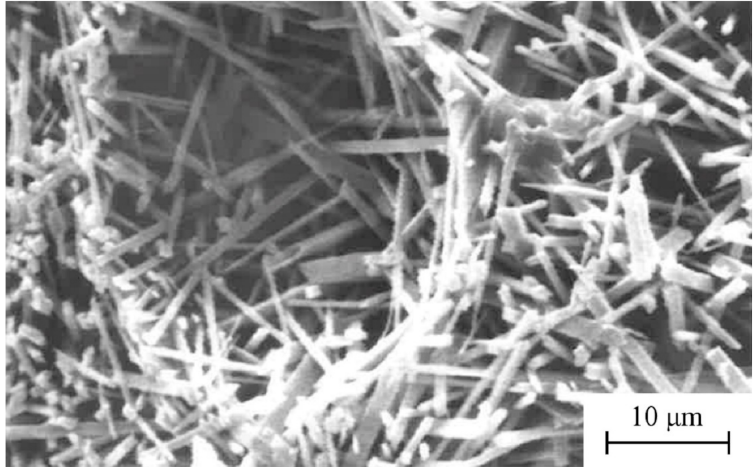
Figure 12. Selected SEM image of the kaolin sample (fraction under 63 µ m) fired at 1300 ◦ C for 2 h after chemical etching using 20 wt % HF aqueous